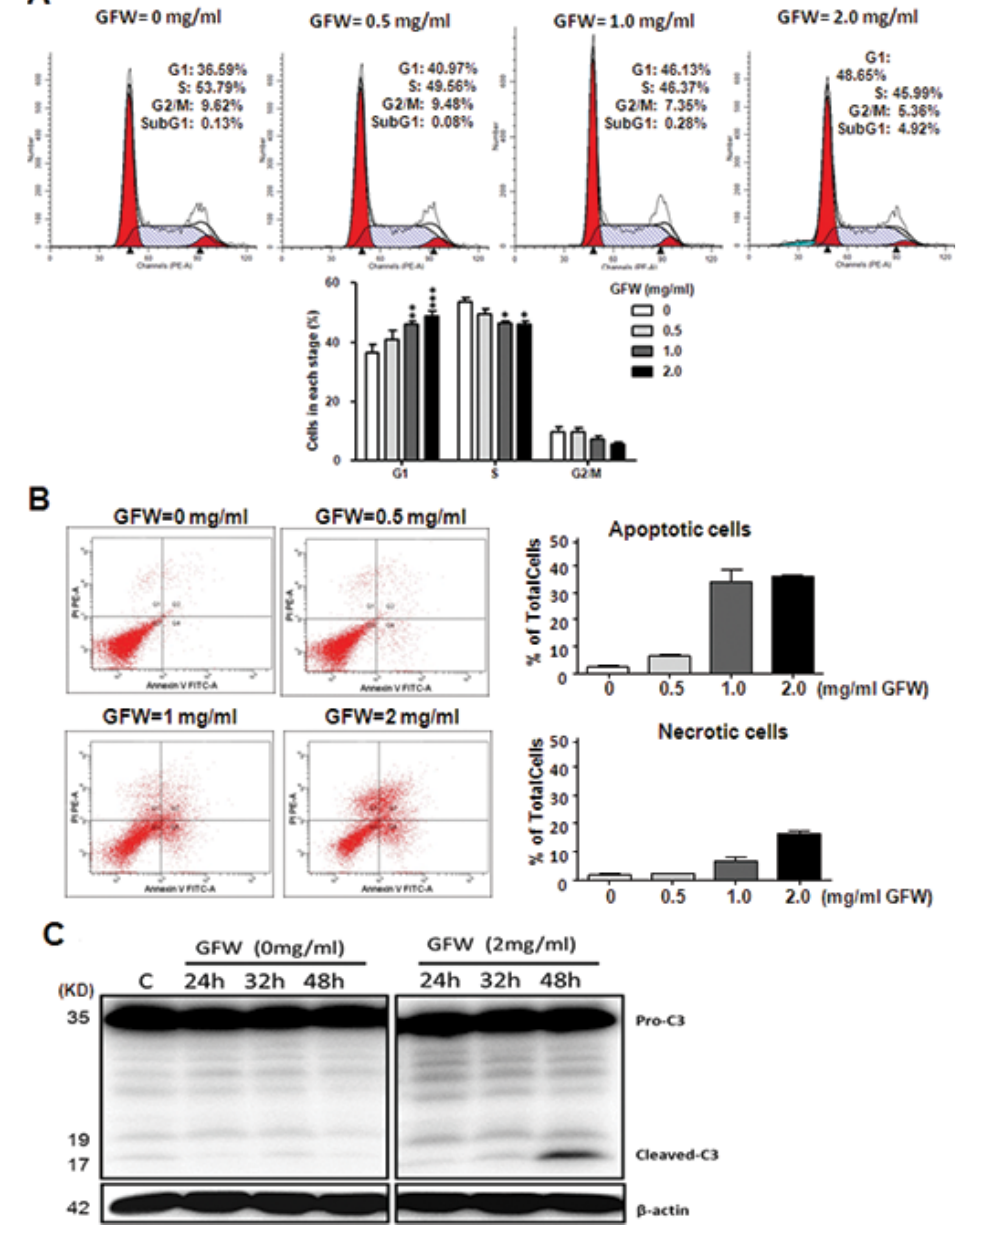
Figure 2. Effects of GFW on cell cycle and induction of apoptosis in mouse urothelial cell line, MB49. (A) MB49 cells were treated with GFW at concentrations of 0.5, 1 and 2 mg/mL for 24 h and then stained with propidium iodide and analyzed using flow cytometry. Data are represented as mean ± SEM (n = 4). Significant differences from the control are indicated by * p < 0.05, ** p < 0.01 or *** p < 0.001, as de- termined by one-way ANOVA and Dunnett comparison test. (B) Analysis of apoptosis using flow cytometry. MB49 cells were treated with GFW at concentrations of 0.5, 1 and 2 mg/mL for 24 h, stained with propidium iodide and Annexin V and then analyzed using flow cytom- etry. The lower left quadrant (Q3) represents viable cells, the upper left quadrant (Q1) represents necrotic cells, the lower right quadrant (Q4) represents early apoptotic cells and the upper right quadrant (Q2) represents nonviable late apoptotic cells. The relative percent- ages include early and late apoptotic cells. Data are represented as mean ± SEM of three independent experiments. Significant differ- ences from the untreated control are indicated by * p < 0.05, ** p < 0.01 or *** p < 0.001, as determined by one-way ANOVA and Dunnett comparison test. (C) Analysis of caspase-3 activation in GFW-treated cells. Western blot analysis was performed to detect caspase-3 and its cleaved form in MB49 cells after treatment with 2 mg/mL GFW for various durations. β -Actin protein was used as the loading